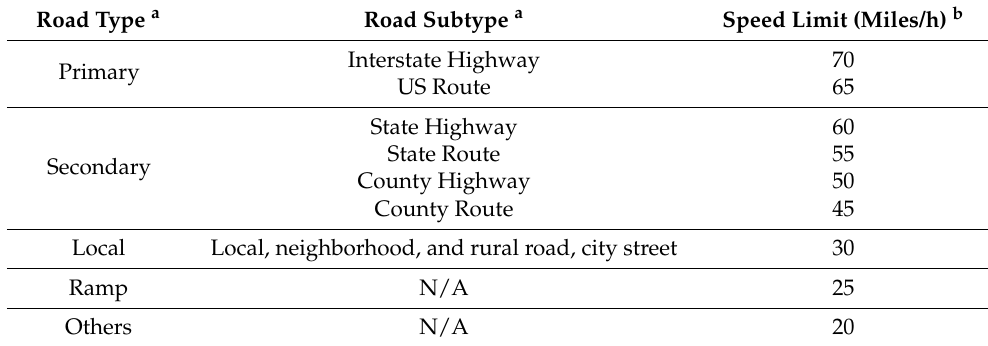
Table A4. Criterion for assigning speed limits to road